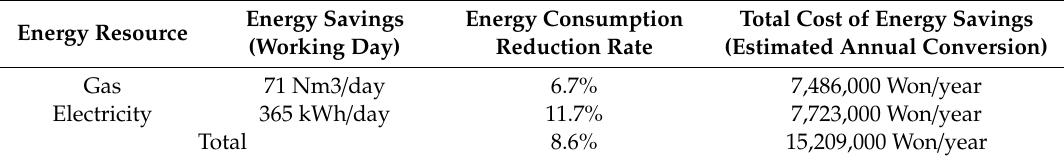
Table 2. Test results using e-Brain in the platform.